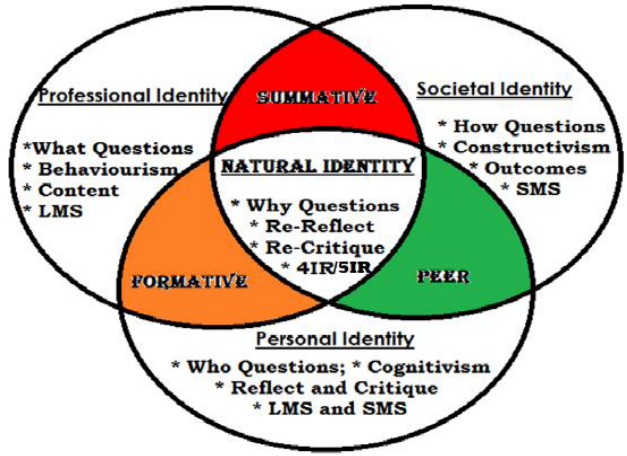
Figure 1. Natural identity framework (NIF) adapted from Khoza [23].